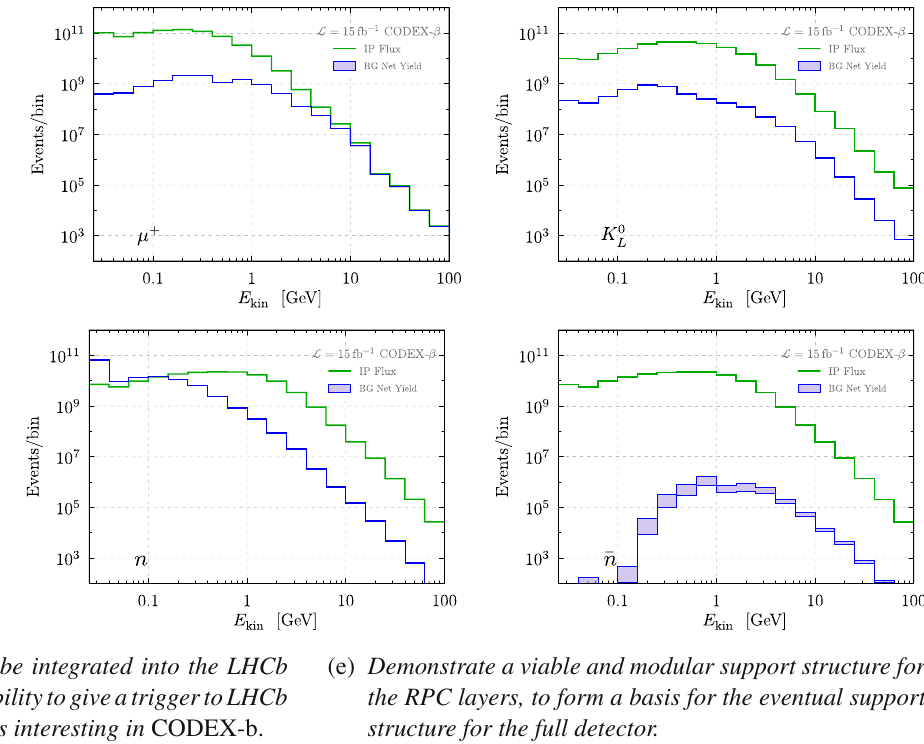
(c) Show that CODEX-b can be integrated into the LHCb DAQ anddemonstrateanabilitytogiveatrigger toLHCb to retain an event that looks interesting in